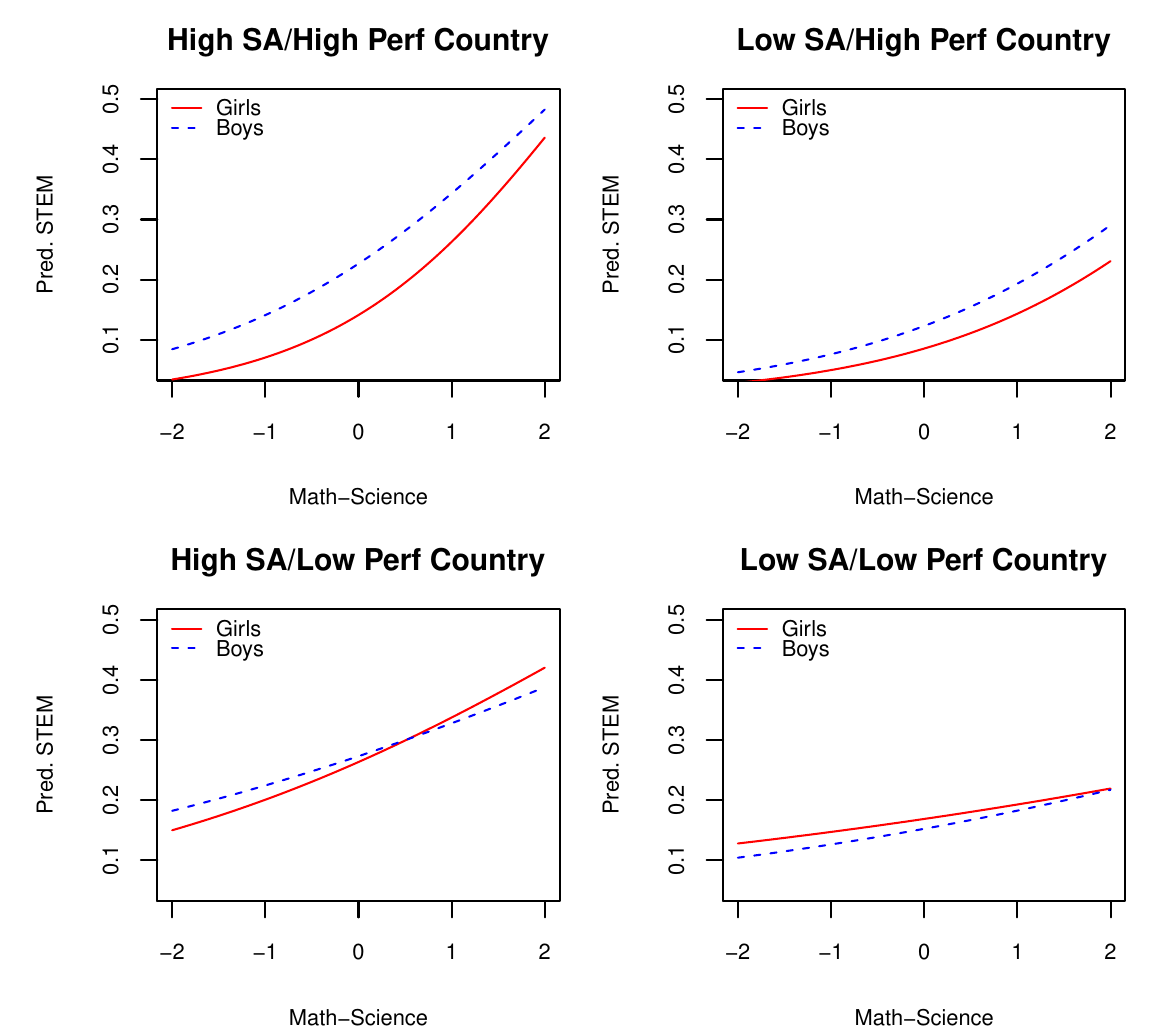
Figure 5: Predictive margins for boys and girls on the STEM orientation returns to math-science performance by the national self-assessment